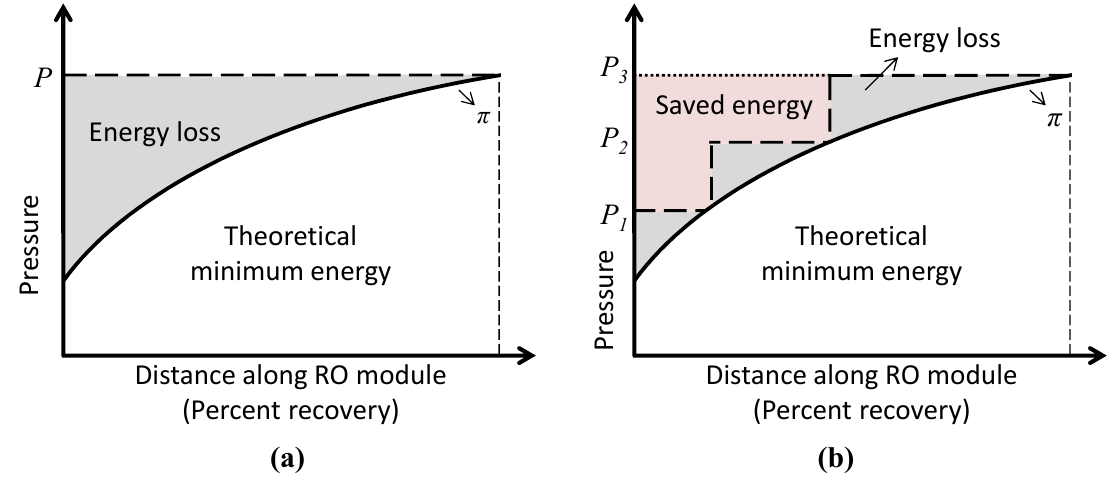
Figure 3. Energy usage of a reverse osmosis (RO) system and the effect of longitudinal concentration gradient. The theoretical minimum energy demand for desalination, which is represented by the area under the osmotic pressure curve, is equal to the energy needed to bring saline water to the maximum osmotic pressure in the corresponding module. ( a ) For single-stage system, the operation pressure P must be at least equal to the osmotic pressure π of the solution at the outlet of membrane module. The applied energy is represented by the area under the dashed line. The difference between these two areas (gray area) is the provided extra energy, i.e. , energy loss. ( b ) For 3-stage system, by providing appropriate pressure for each stage, the energy loss (gray area) is reduced, and some of the extra energy is saved (pink area)—based on